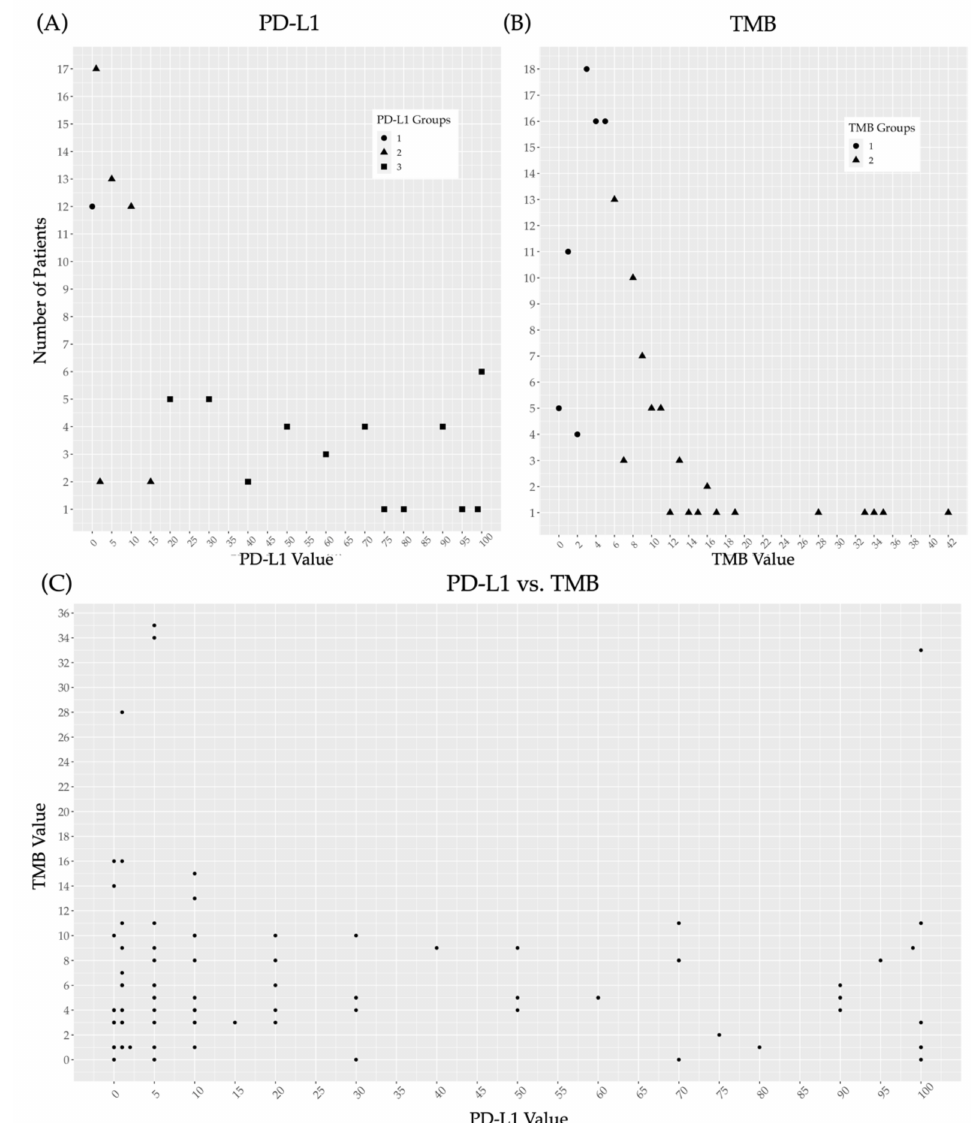
Figure 2. Distribution of continuous PD-L1 and continuous TMB and scatter plot demonstrating the relationship between each. ( A ) Distribution of PD-L1 across 3tPD-L1-(0) (group 1, circles), 3tPD-L1-(1–19) (group 2, triangles) and 3tPD-L1-(20+) (group 3, squares); ( B ) Distribution of TMB across TMB-(<6) (group 1, circles) and TMB-(6+) (group 2, triangles); ( C ) Scatter plot demonstrating the failure of PD-L1 to correlate to TMB. Abbreviations: PD-L1, programmed death ligand-1; and TMB, tumor mutational